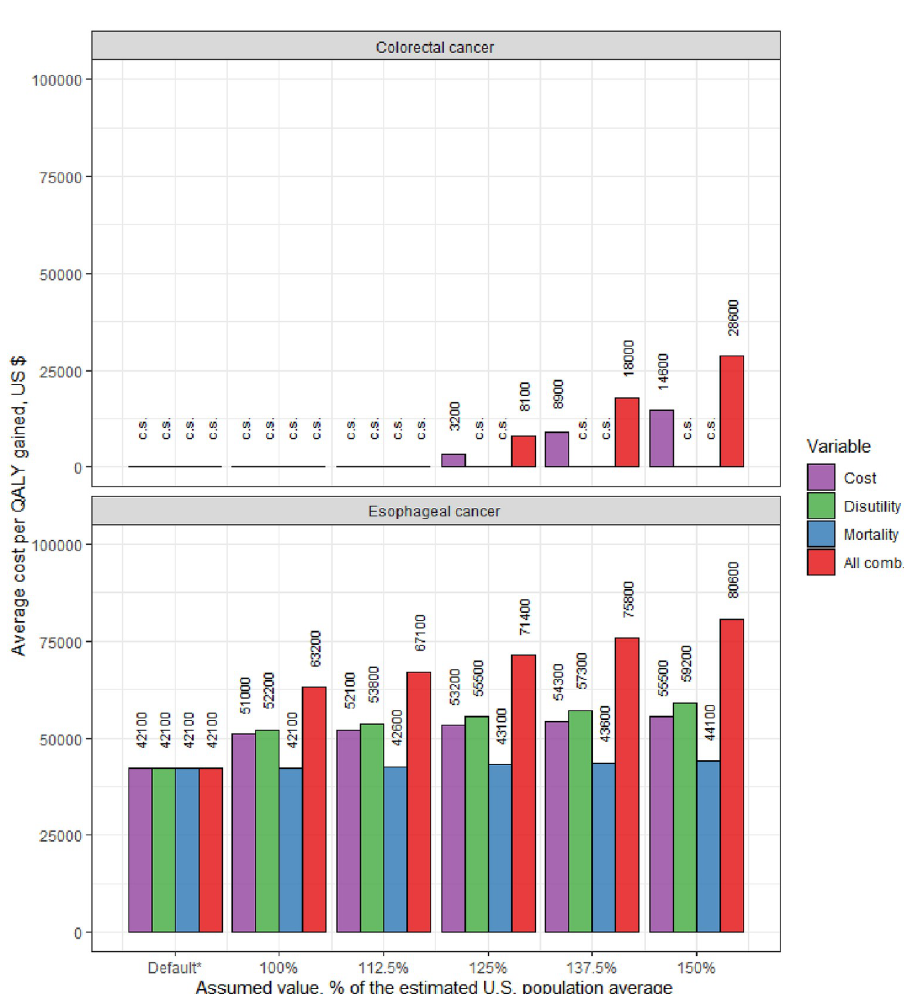
Fig 2. Impact of various assumptions for the health-related costs, disutility and mortality on the average cost- effectiveness of recommended screening strategies for colorectal cancer a and esophageal adenocarcinoma. b,c � Abbreviations: comb. = combined; c.s.: cost-saving. a Colonoscopy every 10y from age 50 through 75; b Endoscopy at age 60 in men with gastroesophageal reflux symptoms. c Figure shows independent and combined effects of the costs, disutility and mortality from other causes of morbidity (Fig 1) on the cost per QALY gained vs . no screening. The X- axis represents the assumed costs, disutility and mortality for precancerous patients relative to the general population. � Default scenario with average mortality, without health-related costs and